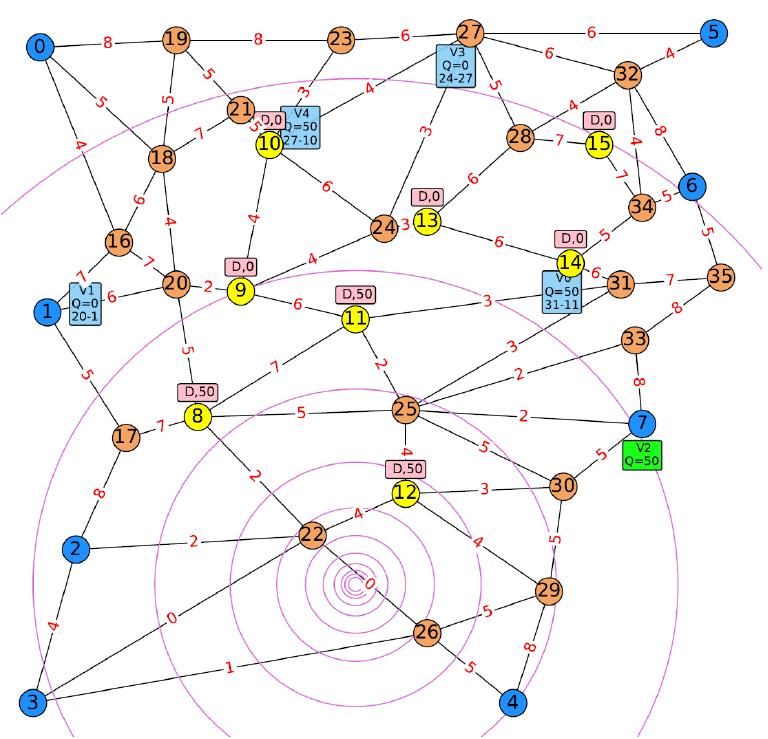
Figure A11. Example of medical supply delivery in progress for the network